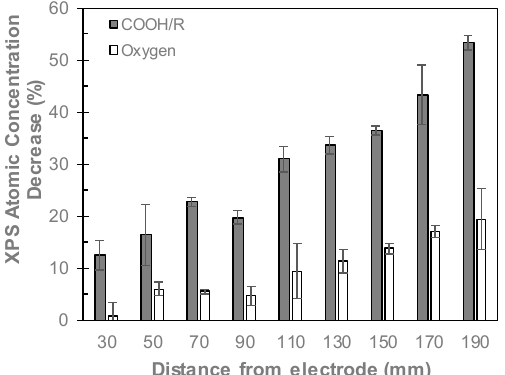
Figure 5. Percentage decrease of XPS COOH / R and oxygen concentrations of ppAAc films after aqueous immersion as a function of distance from the electrode (error bars ± standard deviation).